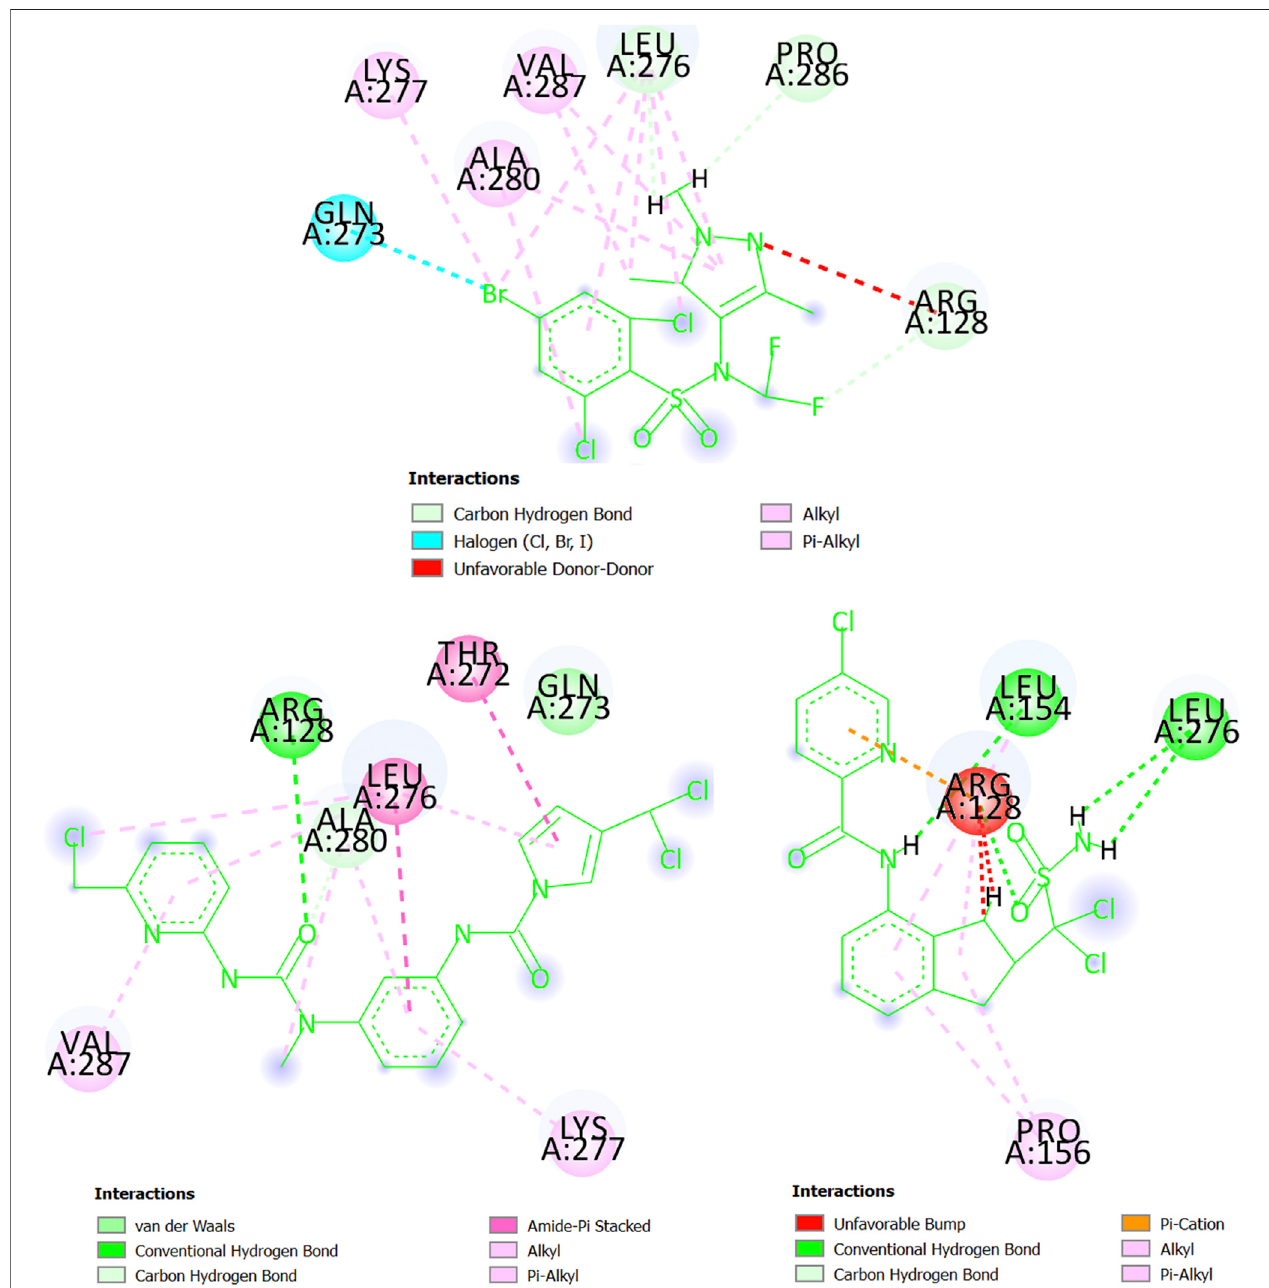
FIGURE 10 | Amino acids of the binding site of glycylpeptide N-tetradecanoyltransferase ( T. brucei brucei ) interacting with CHEMBL3959734 (top center) , MTIPP-002 (left bottom) and MTIPP-004 (right bottom) .